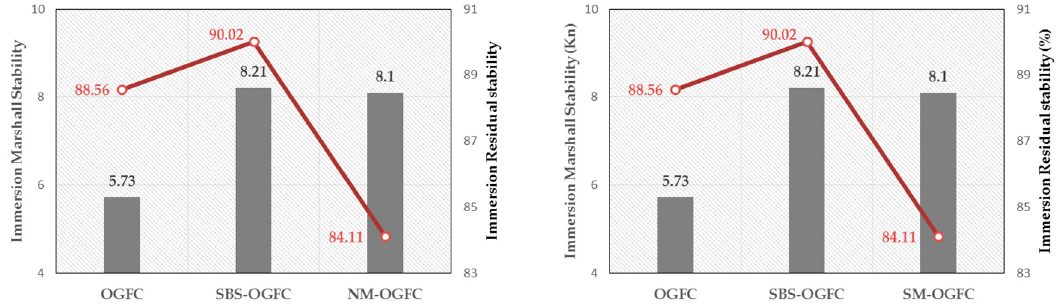
Figure 12. Immersion Marshall stability and Immersion residual stability for all OGFC stability.